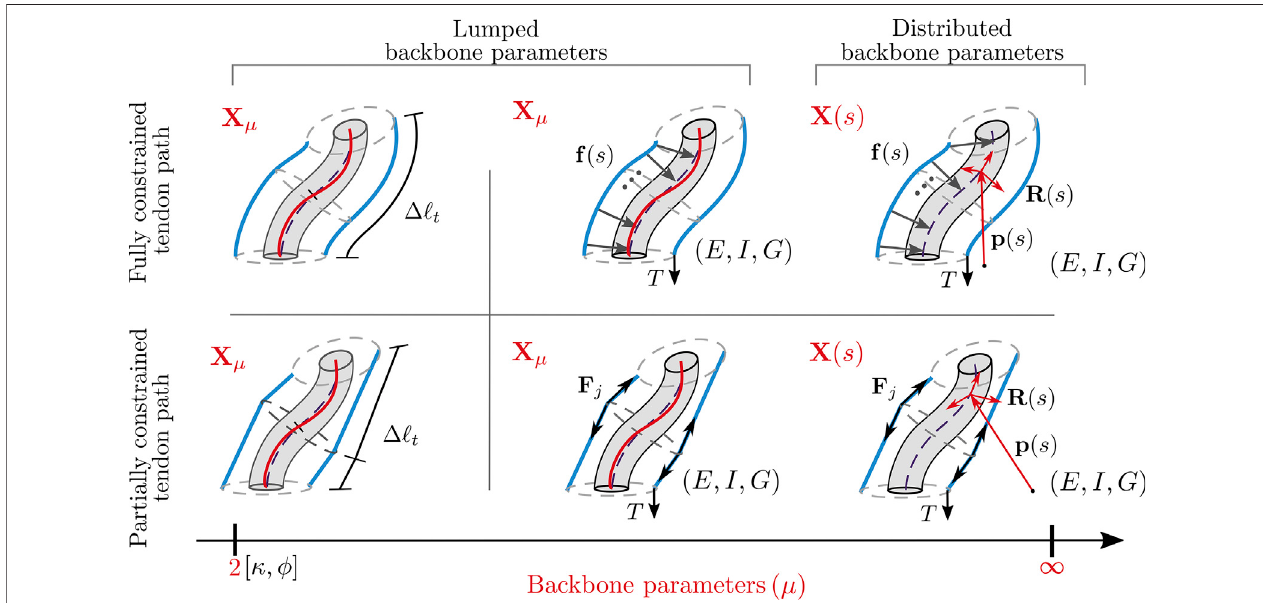
FIGURE 8 | Proposed classi fi cation of different modelling approaches based on the backbone parameters required to de fi ne the backbone and assumed tendon path.Theleftcolumnshowspurekinematicmodelling,whichmapsthetendonlengthstothebackboneposewhilethestaticsmodellingintherightcolumnconsidersthe backbone properties such as Young ’ s modulus ( E ), moment of inertia ( I ), shear modulus ( G ) as well as the effect of resulting tendon forces ( f ( s ) or F j ) acting on it.